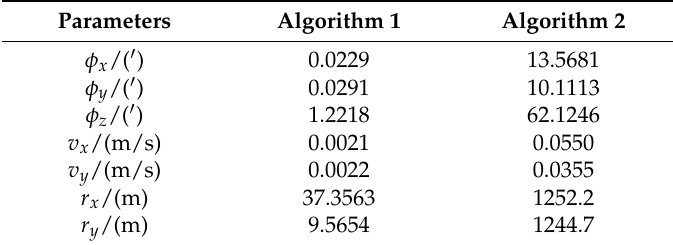
Table 2. RMS errors of Algorithm 1 and Algorithm 2 in the